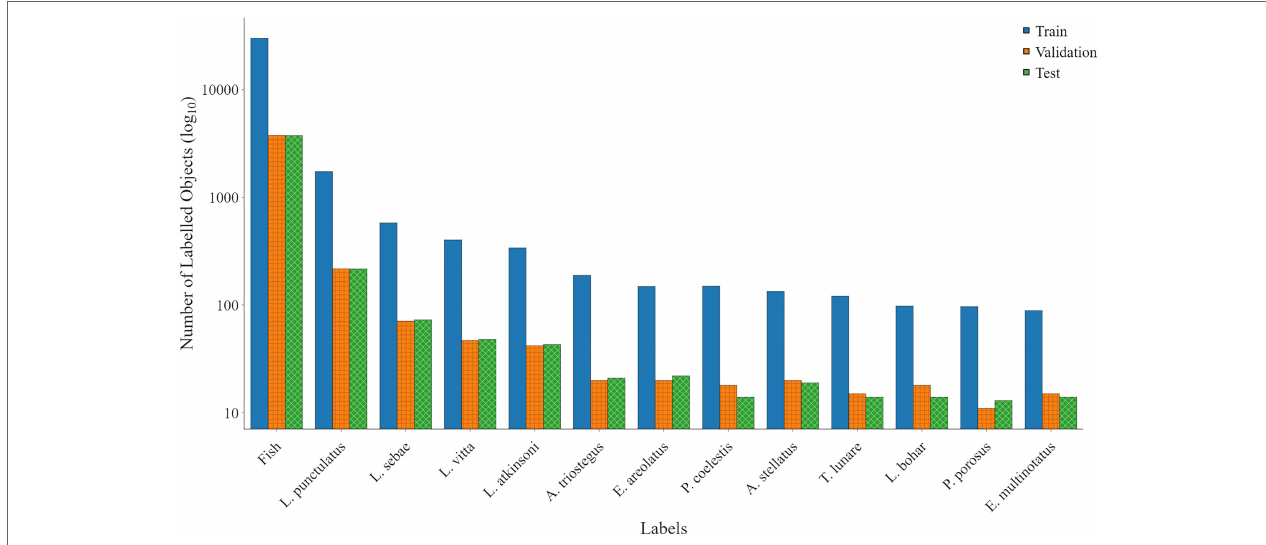
FIGURE 3 | Data used for training YOLOv5. The train, validation, and test data were split at a ratio of 66%, 17%, and 17%, respectively, between classes, chosen to optimise the number of test classes available